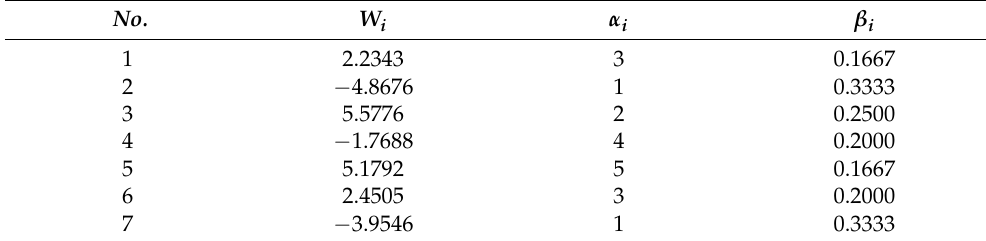
Table 1. Corresponding parameters of system (1).